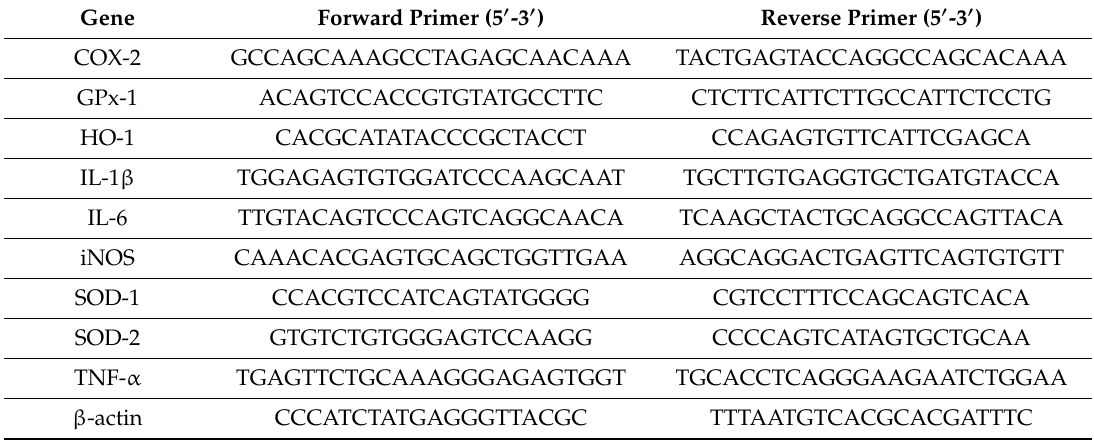
Table 1. The nucleotide sequences of the primers used in real time